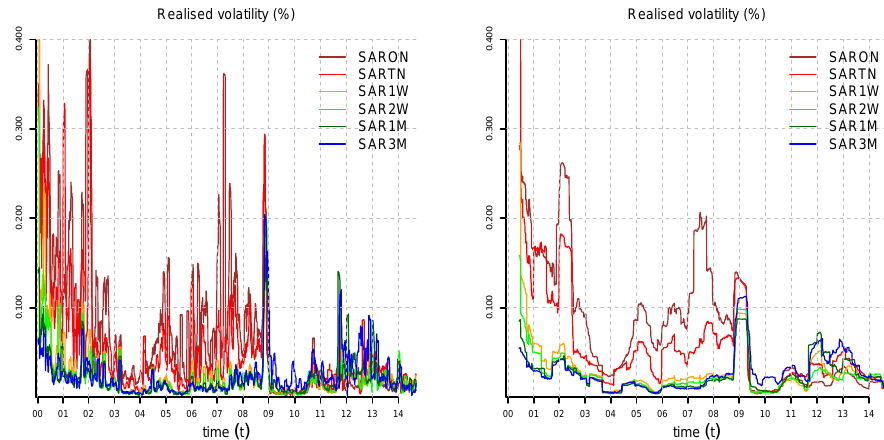
(cid:92) RCov ( t , τ , τ ) 1 2 for τ = 1,2,5,10,21,63, window length K = 21 (lhs)